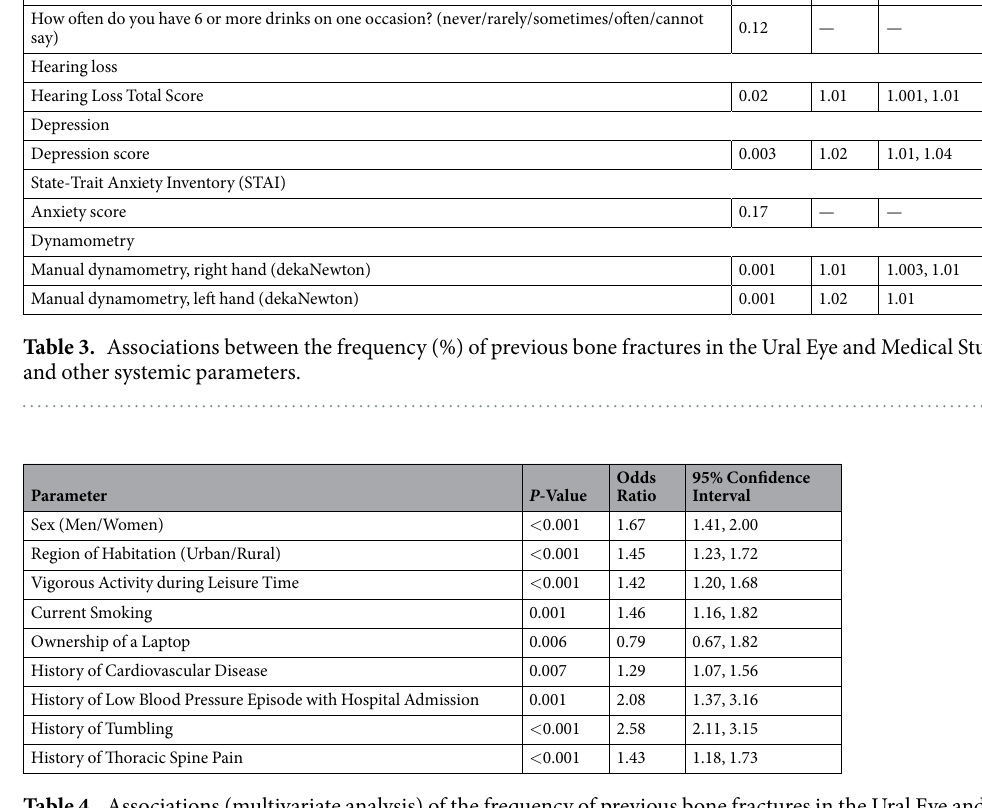
Table 4. Associations (multivariate analysis) of the frequency of previous bone fractures in the Ural Eye and Medical